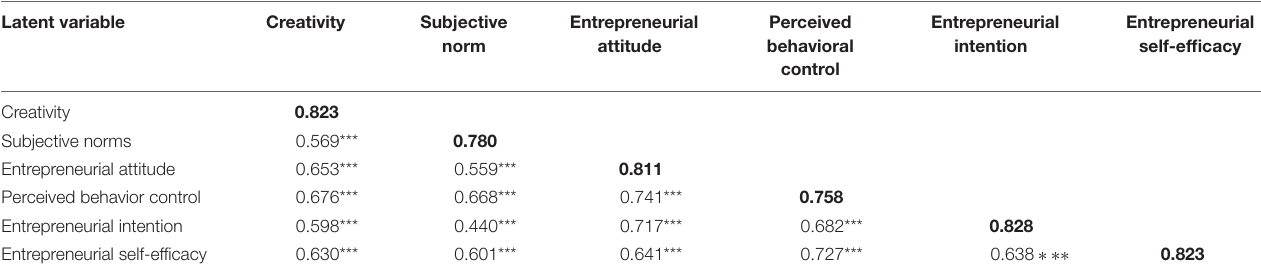
TABLE 3 | Discriminant validity